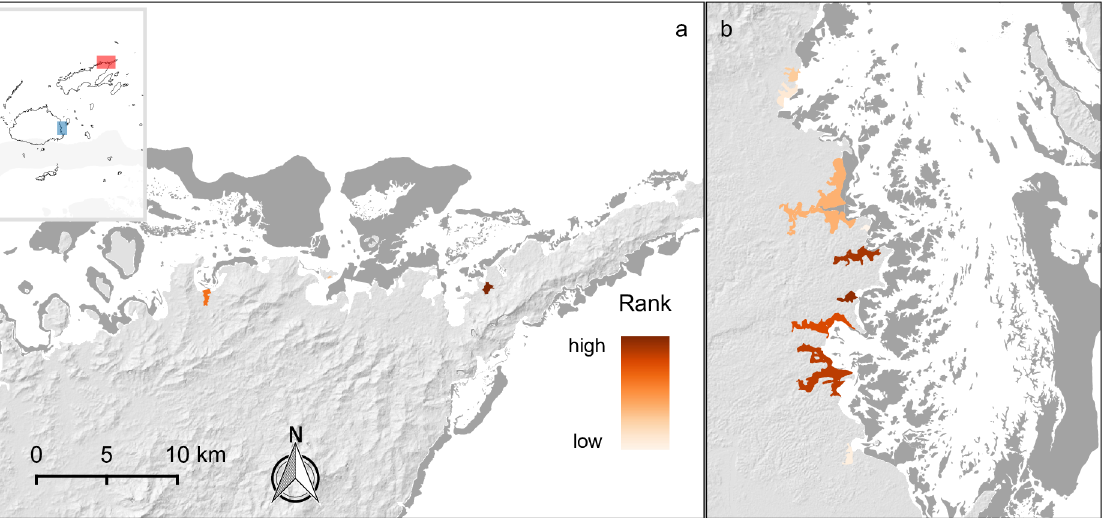
Fig 5. Priority sites for fisheries services. The highest ranked priority site was found on north-eastern Vanua Levu (panel a, red inset polygon) but a large clumping of the highest ranking priority sites occurred north of the Rewa Delta (panel b, blue inset polygon) on eastern Viti Levu. Dark grey areas are coral